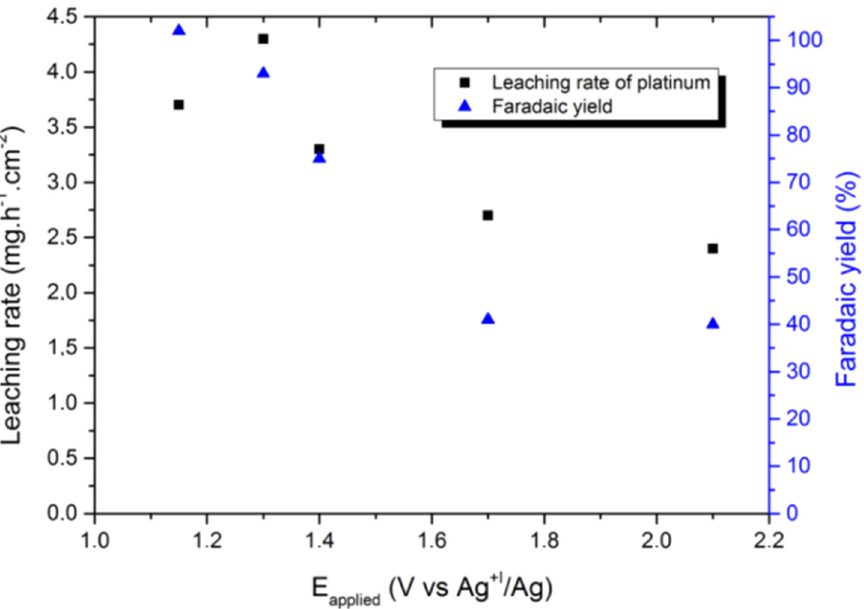
Figure 12. Effect of the applied potential on the leaching rate of platinum and the corresponding Faradaic yield in runs conducted at Q = 55 C ∙ cm − 2 . Reproduced with permission [89] . Copyright 2018, Creative Commons.